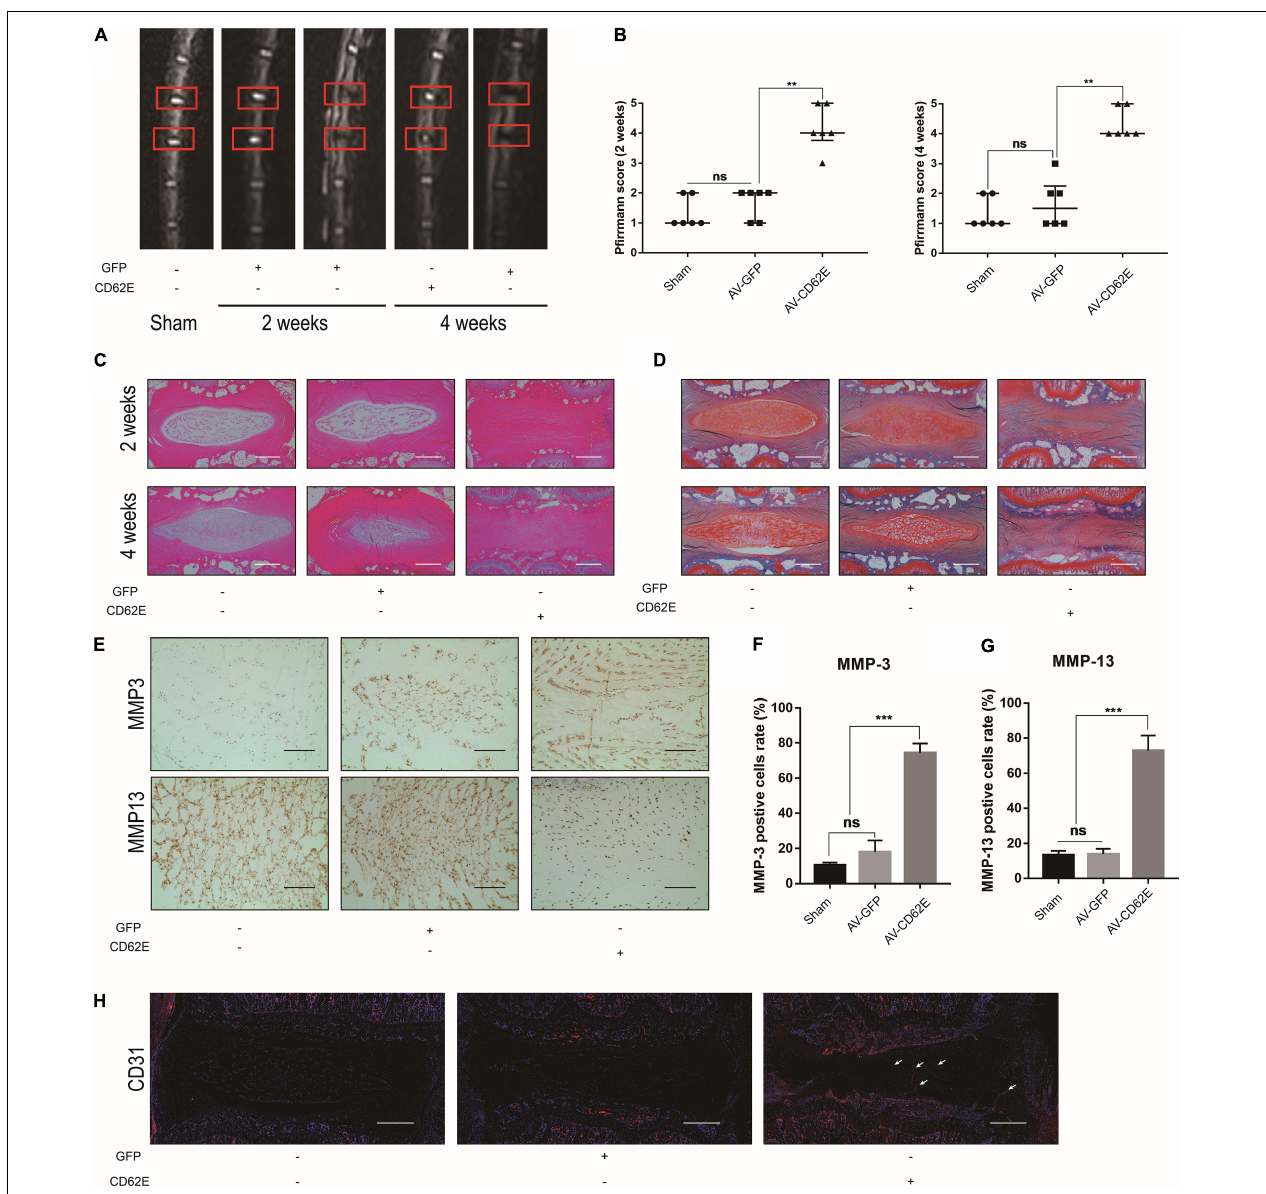
FIGURE 8 | Effects of AV-CD62E on rat IDD model. (A) T2-weighted MRI images of rat tail at 2 and 4 weeks post-surgery (red boxes: needle-puncture disc locations). (B) Pfirrmann MRI scores ( n = 6). (C) Representative H&E and (D) Safranin O/Fast Green staining images. (E) IHC images of MMP-3 and MMP-13 and (F,G) quantification. (H) CD31 IF images. Black scale bar: 100 µ m. White scale bar: 500 µ